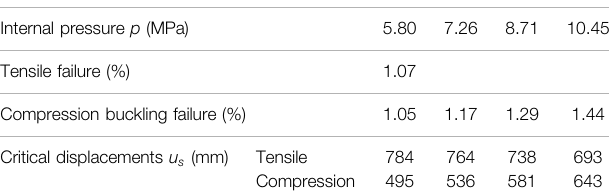
TABLE 2 | The results of critical displacements in the thawing landslide of soil under an ultimate strain.